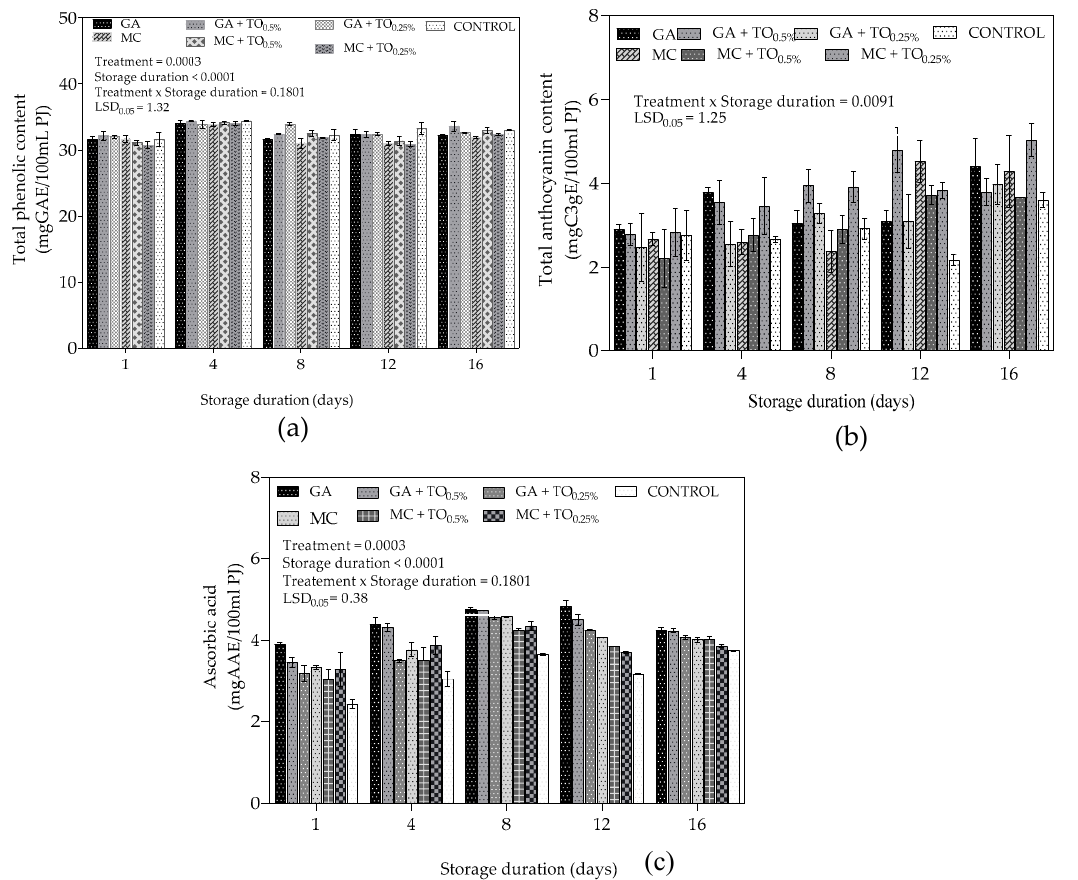
Figure 5. ( a ) Total phenolic content (mgGAE/100 mL PJ), ( b ) total anthocyanin content (mgGAE/100 mL PJ) and ( c ) ascorbic acid (mgAAE/100 mL PJ) “Acco” pomegranate arils coated with gum arabic and methyl cellulose coatings enriched with thyme oil (0.5% and 0.25%) and stored at 5 ± 1 °C (95 ± 2% RH) for 16 days. Error bars represent standard error (SE) of the mean values ± S.E. of three replicates (1 punnet = 1 replicate). LSD 0.05 represent least significant difference ( p < 0.05).